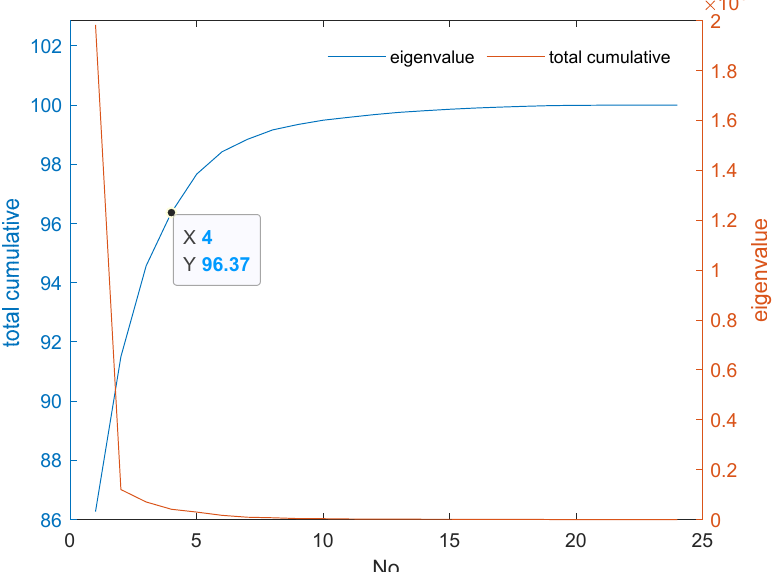
Figure 15. Principal component eigenvalues and cumulative contribution rate of load data.